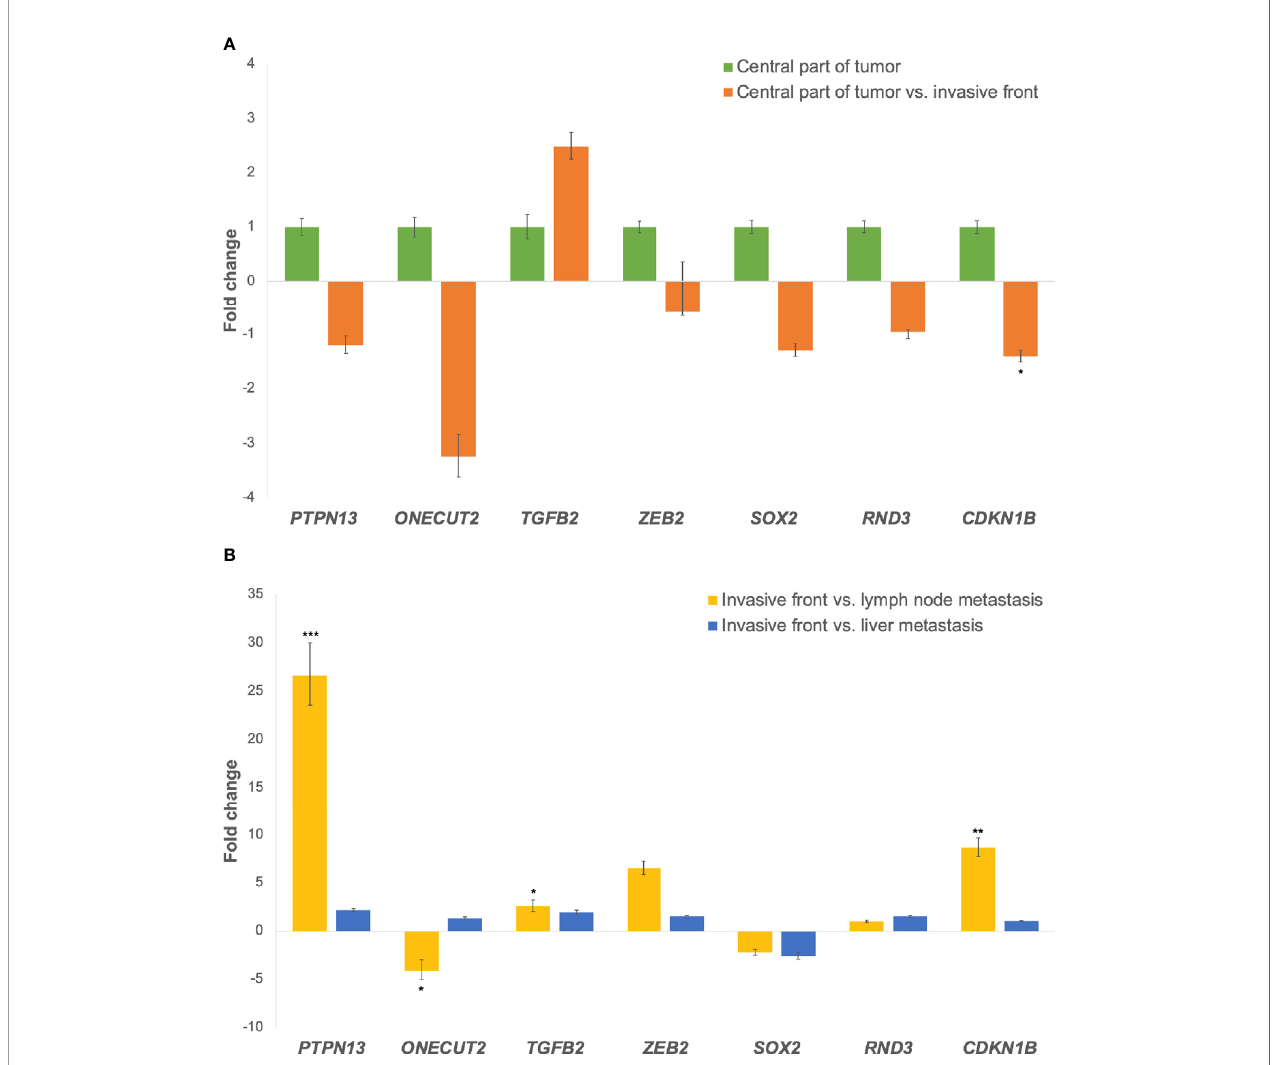
FIGURE 3 | (A) Expression of the miR-200 family target genes at the invasive tumor front in comparison to the central part of the tumor. Legend: *p ≤ 0.05. (B) Expression of the miR-200 family target genes in lymph node and liver metastases in comparison to the invasive tumor front. Legend: *p ≤ 0.05; **p ≤ 0.01; ***p ≤